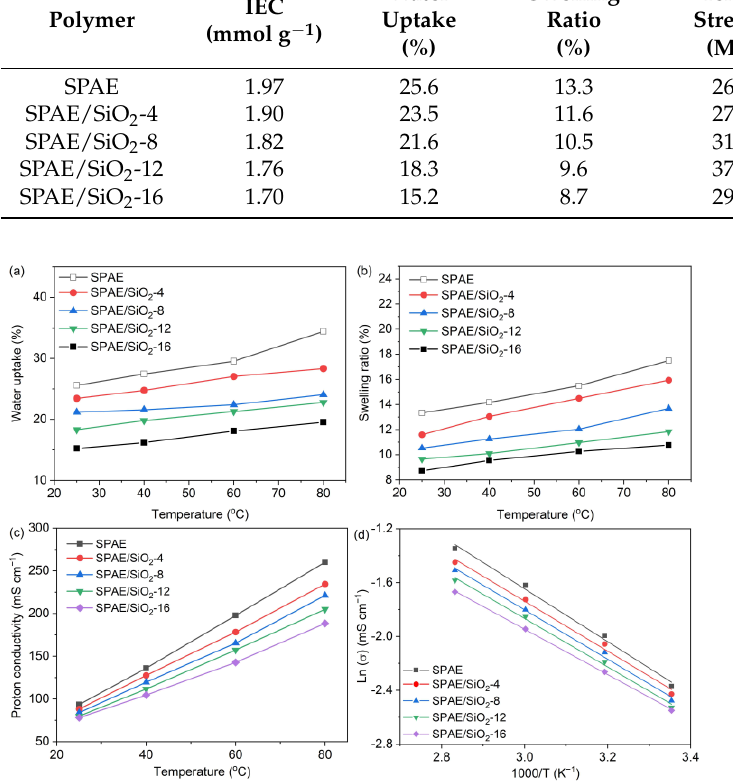
Figure 4. ( a ) Water uptake and ( b ) swelling ratio of the SPAE and SPAE/SiO 2 composite PEMs as a function of temperature, ( c ) proton conductivity, and ( d ) Arrhenius plots of the SPAE and SPAE/SiO 2 composite PEMs.